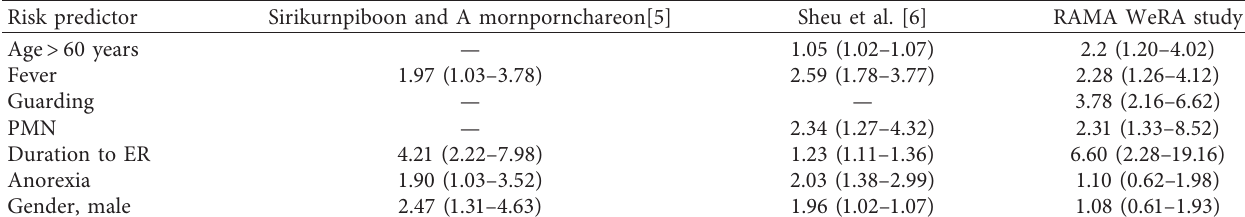
Table 4: Comparison of risk factors for ruptured appendicitis in suspected acute appendicitis patients by various studies. Risk